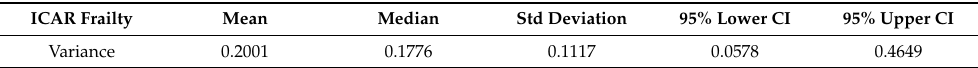
Table 2. Variance of the ICAR frailty